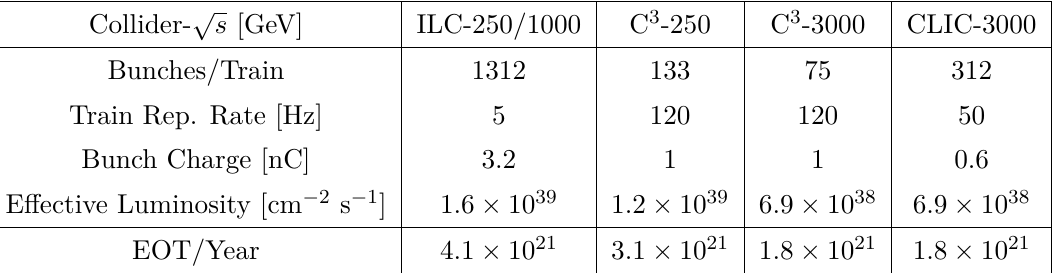
Table 1 . Beam parameters and total number of electrons-on-target (EOT) per year for different e + e − colliders assuming one year of operation. The numbers for the beam parameters are taken from table 4.1 of [60] for ILC, table 3 of [46] for C 3 , and table 4.1 of [61] for CLIC. The “effective luminosity”, L , refers to the instantaneous luminosity of electron-nucleus collisions in the first eff radiation length of the dump (and not to the instantaneous luminosity of the corresponding primary e + e −